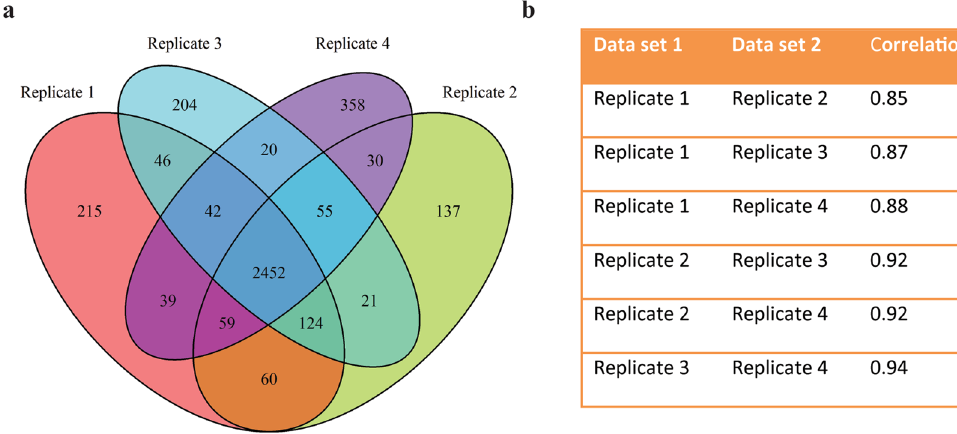
Figure 3. Evaluation of the HiT-Gel method on native protein extracts separated by blue native PAGE. Four biological replicates of native A. thaliana protein extracts were separated by BN-PAGE and prepared for LC-MS/ MS using the HiT-Gel method. (a) The overlap in quantified proteins between all four replicates is shown as a venn diagram. (b) The mean correlation factors for proteins quantified in each of the replicates were calculated and are presented